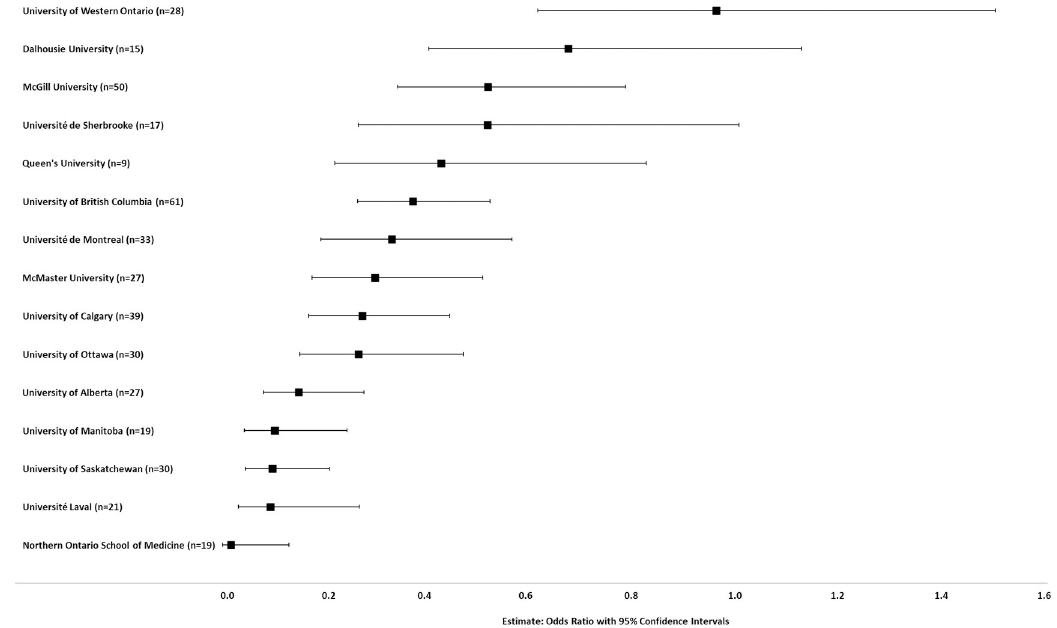
Fig 4. Prediction modeling of the impact of university affiliation on likelihood of women academic surgeons attaining highest levels of promotion (Professor, Professor Emeritus/Honorary Associate Professor/Distinguished Professor). Controlled for specialty and higher degrees. Odds ratio with 95% confidence interval graphed for each university compared to the reference university (University of Toronto, 0.15, highest proportion of women at the highest levels of promotion).